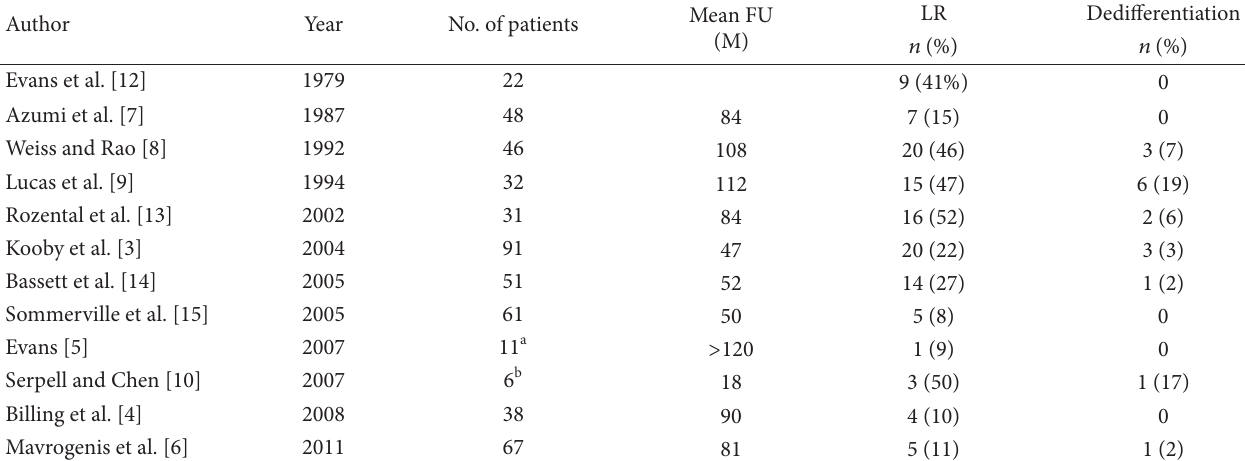
T 3: Summary of outcomes reported for atypical lipomas in select